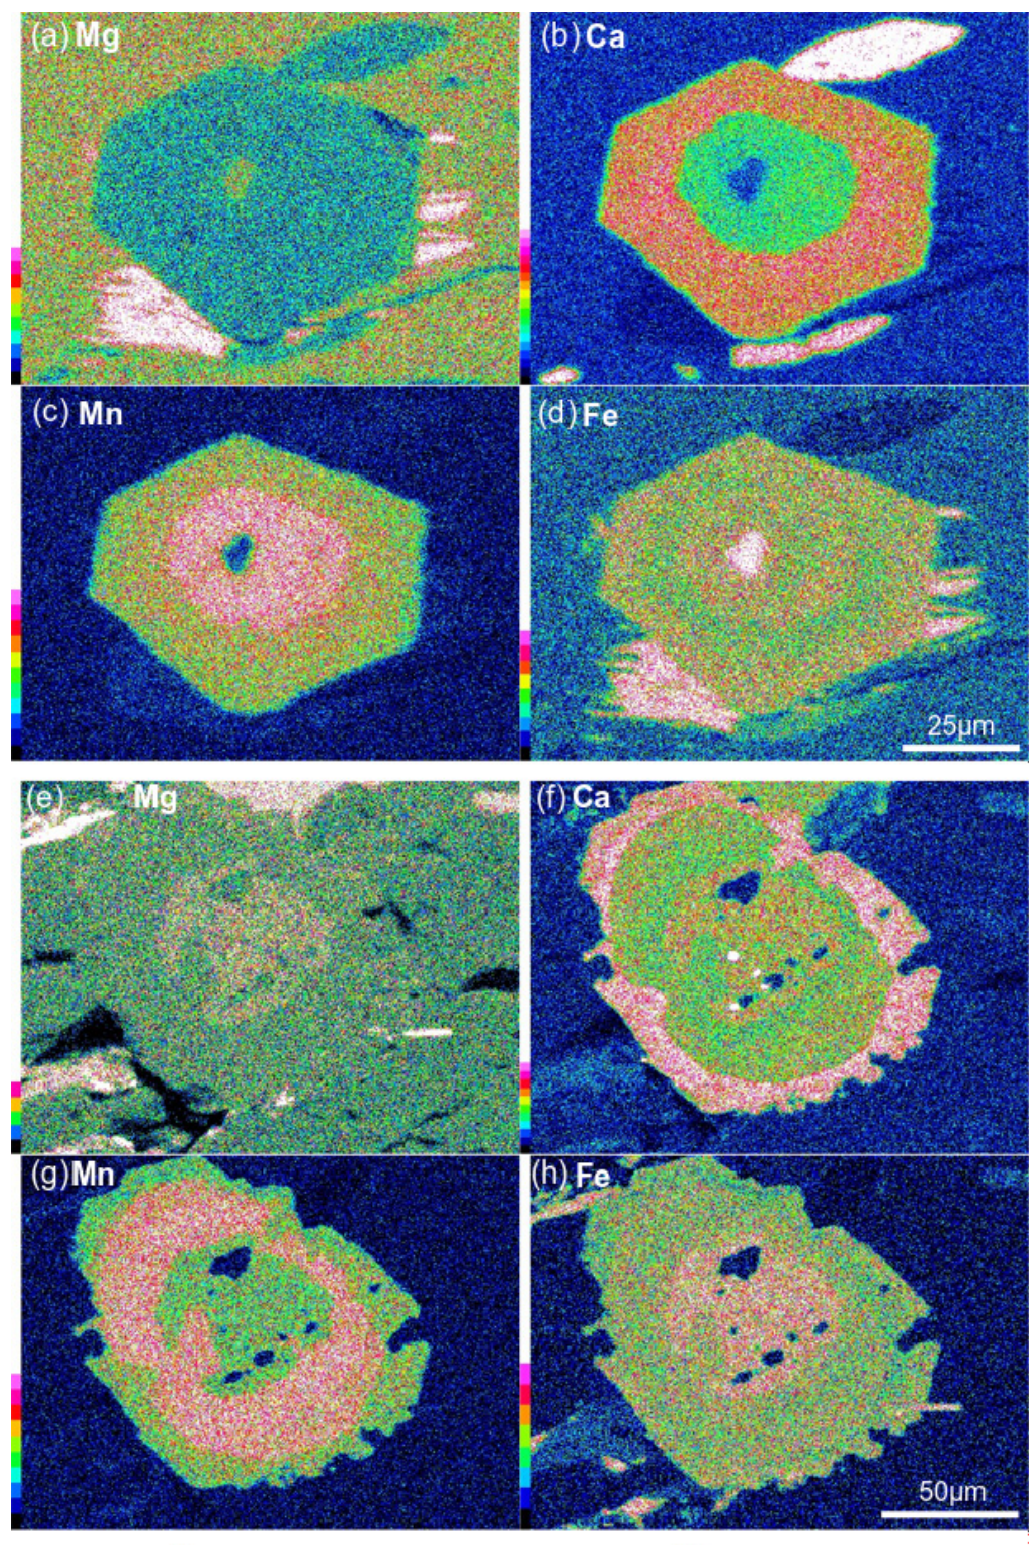
Figure 6. Chemical mapping image of garnet in sample no. 20181125WYF. ( a – d ): Mapped profile of Mg, Ca, Mn, and Fe, respectively, of grain no.65 (Figure 5a,c). An example of the smaller log-normal garnet. ( e – h ): Mapped profile of Mg, Ca, Mn, and Fe, respectively, of grain no.1 (Figure 5e,g). One of the larger garnet grains.